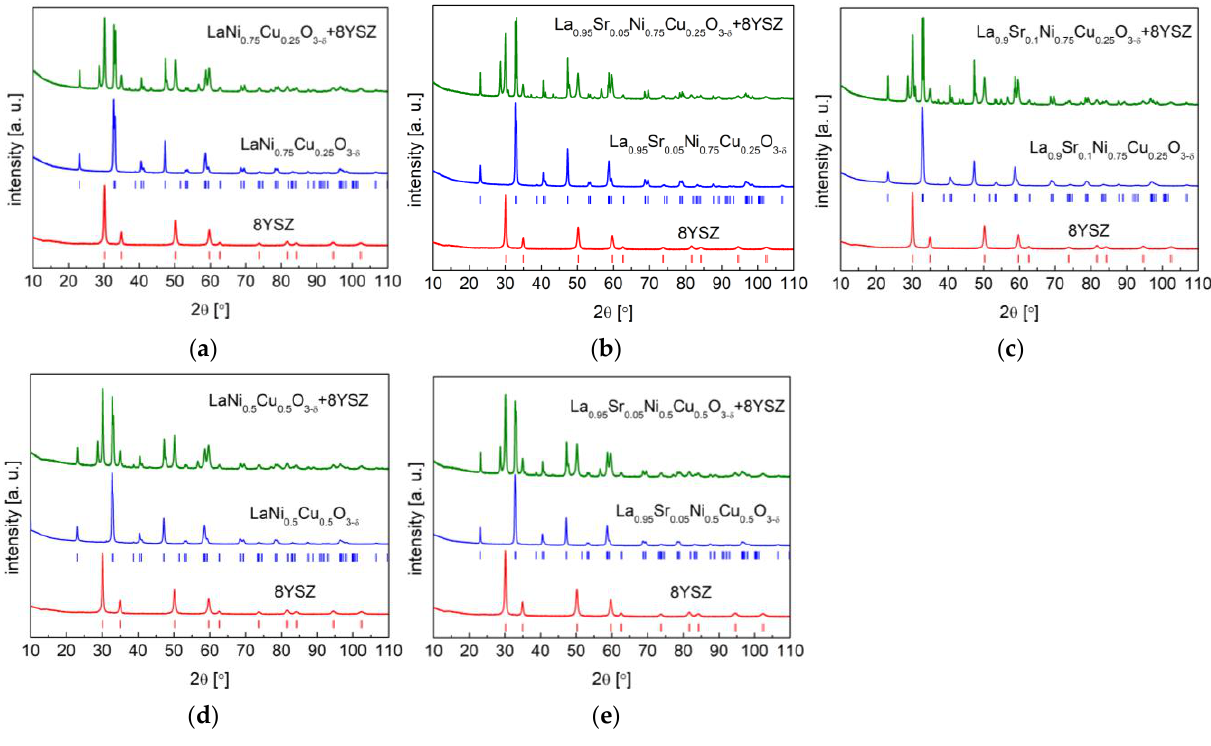
Figure 11. XRD diffractograms of ( a ) LaNi 0.75 Cu 0.25 O 3 − δ ; ( b ) La 0.95 Sr 0.05 Ni 0.75 Cu 0.25 O 3 − δ ; ( c ) La 0.9 Sr 0.1 Ni 0.75 Cu 0.25 O 3 − δ ; ( d ) LaNi 0.5 Cu 0.5 O 3 − δ ; ( e ) La 0.95 Sr 0.05 Ni 0.5 Cu 0.5 O 3 − δ with 8YSZ solid electrolyte after annealing in air at 800 ◦ C for 100 h. 3.4. Electrochemical Performance of IT-SOFC with La 0.95 Sr 0.05 Ni 0.5 Cu 0.5 O 3 − δ A Cu-content La 0.95 Sr 0.05 Ni 0.5 Cu 0.5 O 3 − δ oxide with low TEC (14.1 × 10 − 6 K − 1 ) and high oxygen non-stoichiometry ( δ = 0.22 at 600 ◦ C) was selected as a cathode material for the IT-SOFC, working at around 600 ◦ C (see Figure 12). The scanning electron